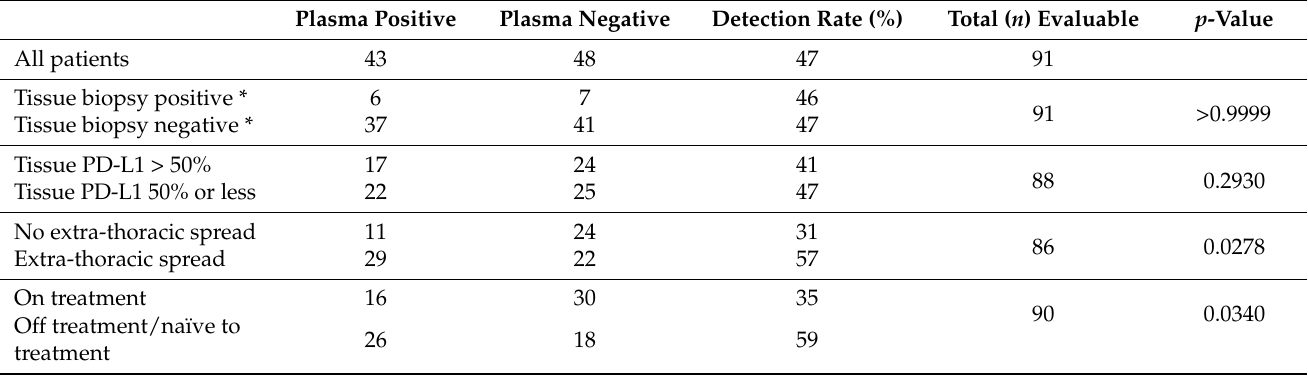
Table 2. Liquid biopsy SNV/indel detection rate per clinicopathological